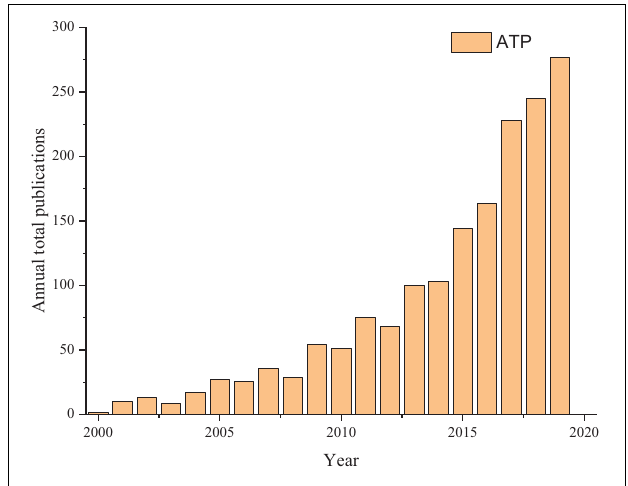
FIGURE 1 | The number of publications in this field from 2000 to 2019. ATP is the annual total